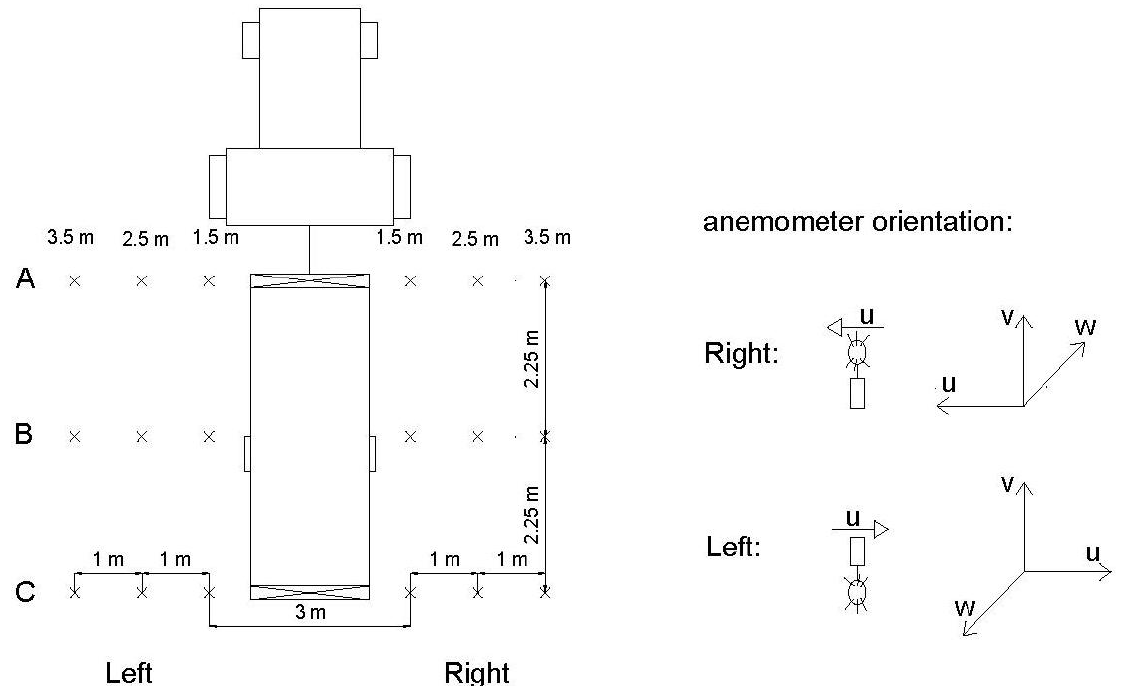
Figure 4. Outline of the measuring points of the static